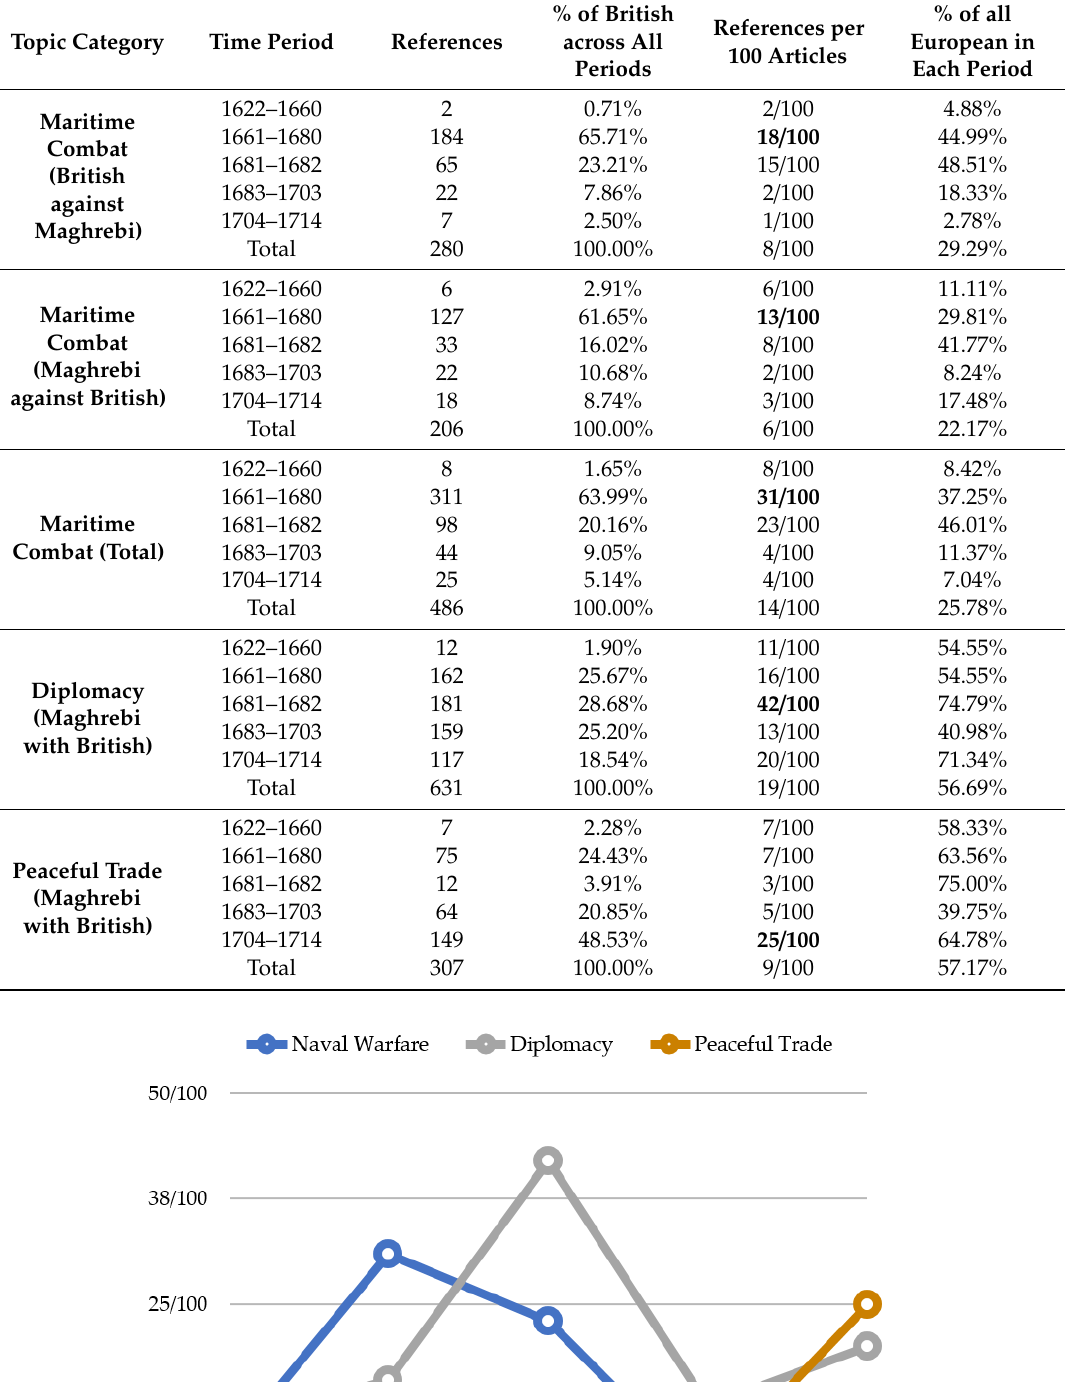
Table 6. References to maritime combat, diplomacy and trade by period (British relations only, highlighting period with highest density of references for each topic).